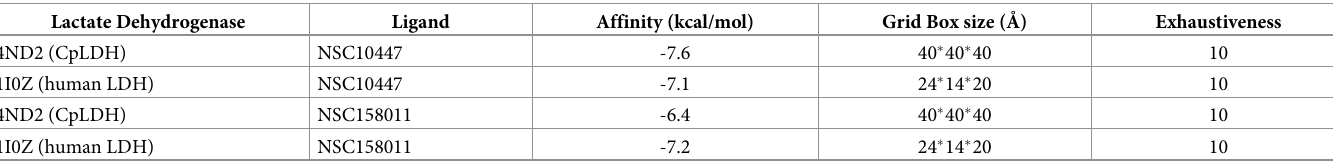
Table) were derived from dose–response curves using GraphPad PRISM software. To test the Table 2. Affinity of the most favorable compound poses within lactate dehydrogenase active site. Lactate Dehydrogenase